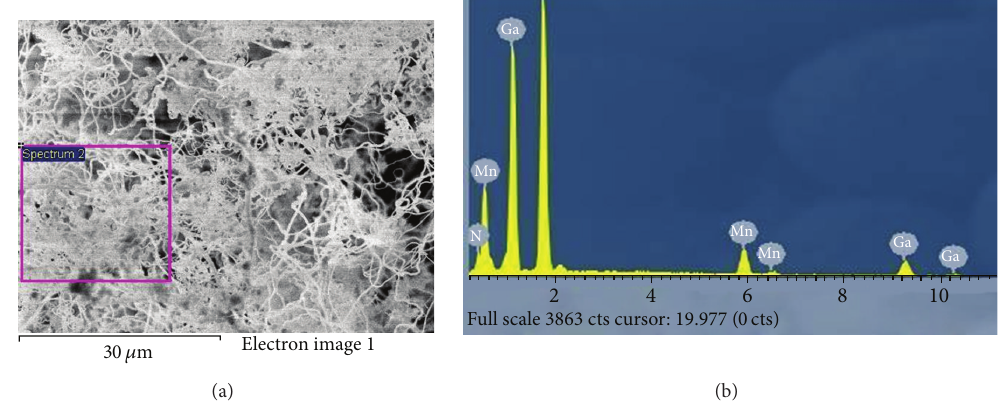
Figure 4: Typical EDS spectrum data of the GaN:Mn nanowires.